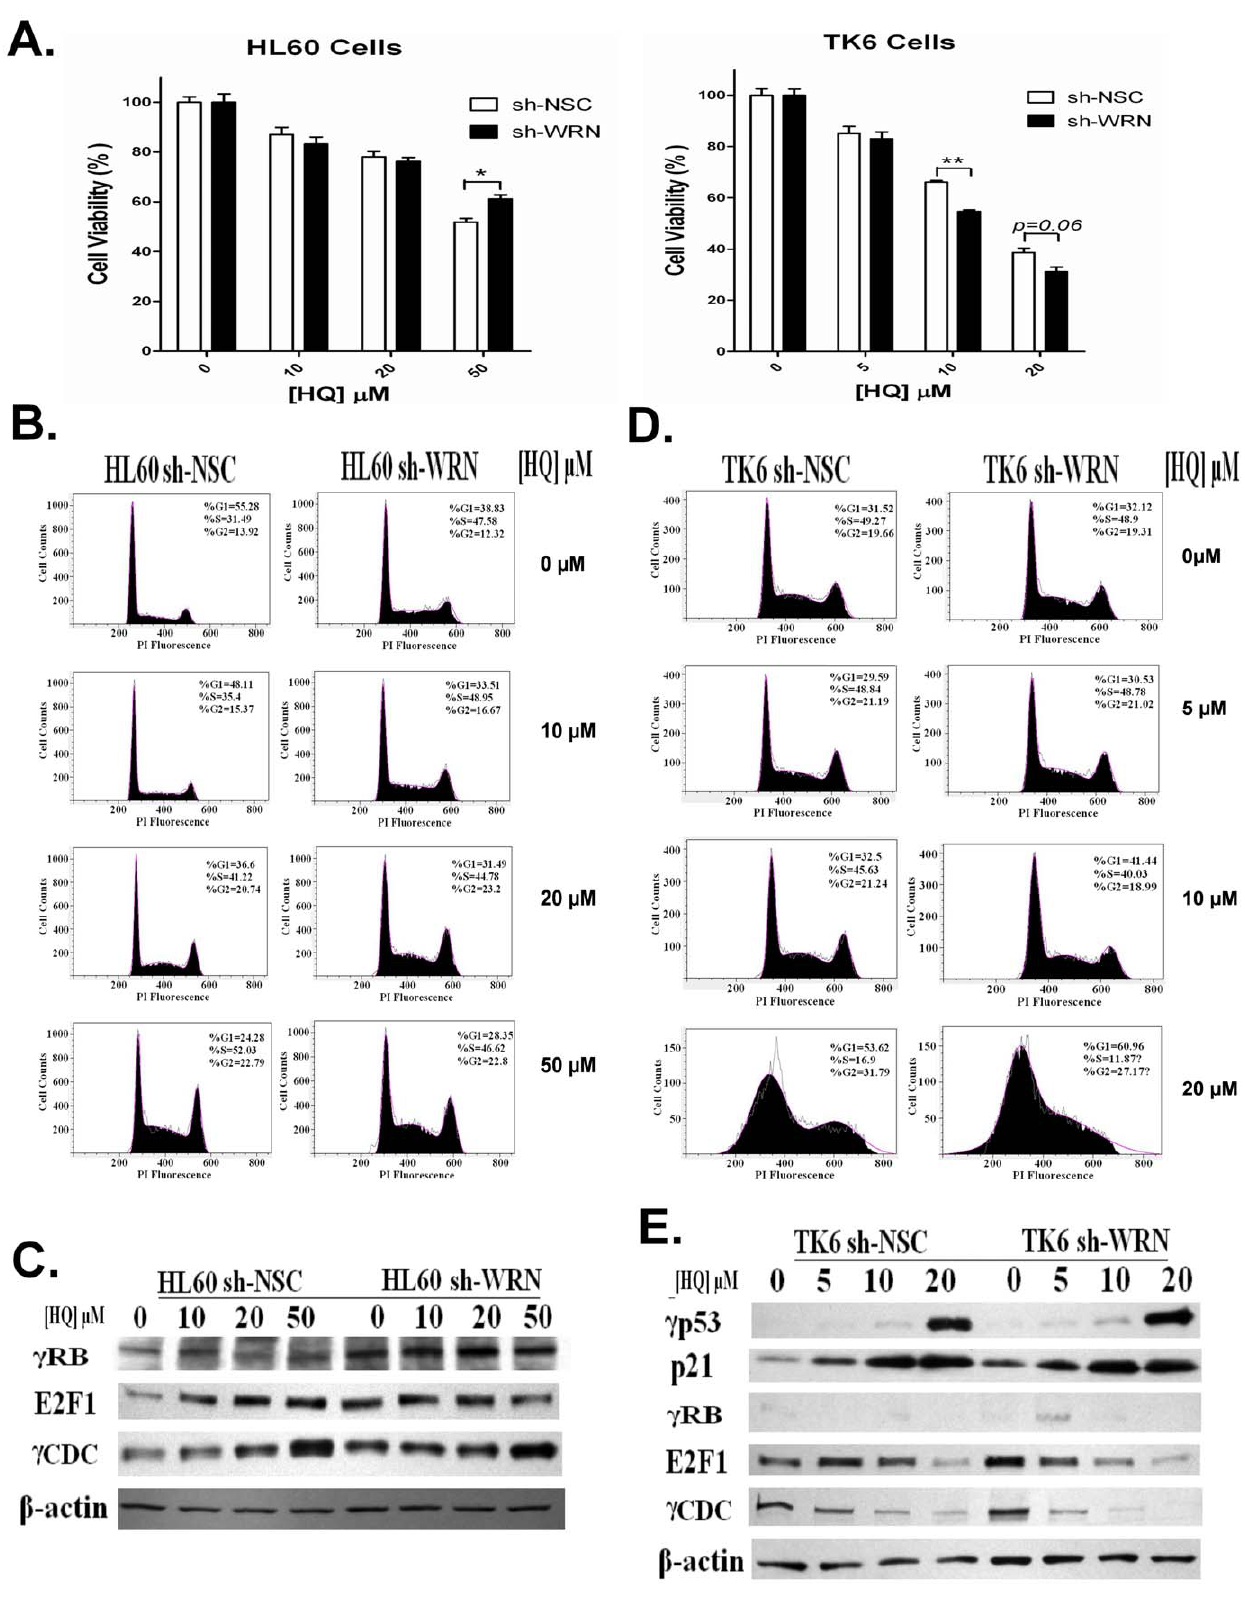
Figure 3. Silencing WRN leads to a differential response to HQ treatment between HL60 and TK6 cells. (A) Cells were exposed to HQ for 24 hours and the cell number and viability were calculated using a hemocytometer and the trypan blue exclusion assay. (B) Cell cycle analysis showed HQ exposure induced a dose-dependent decrease of G1-phase and an increase of cells in S and G2 phase in HL60 sh-NSC cells. In contrast,